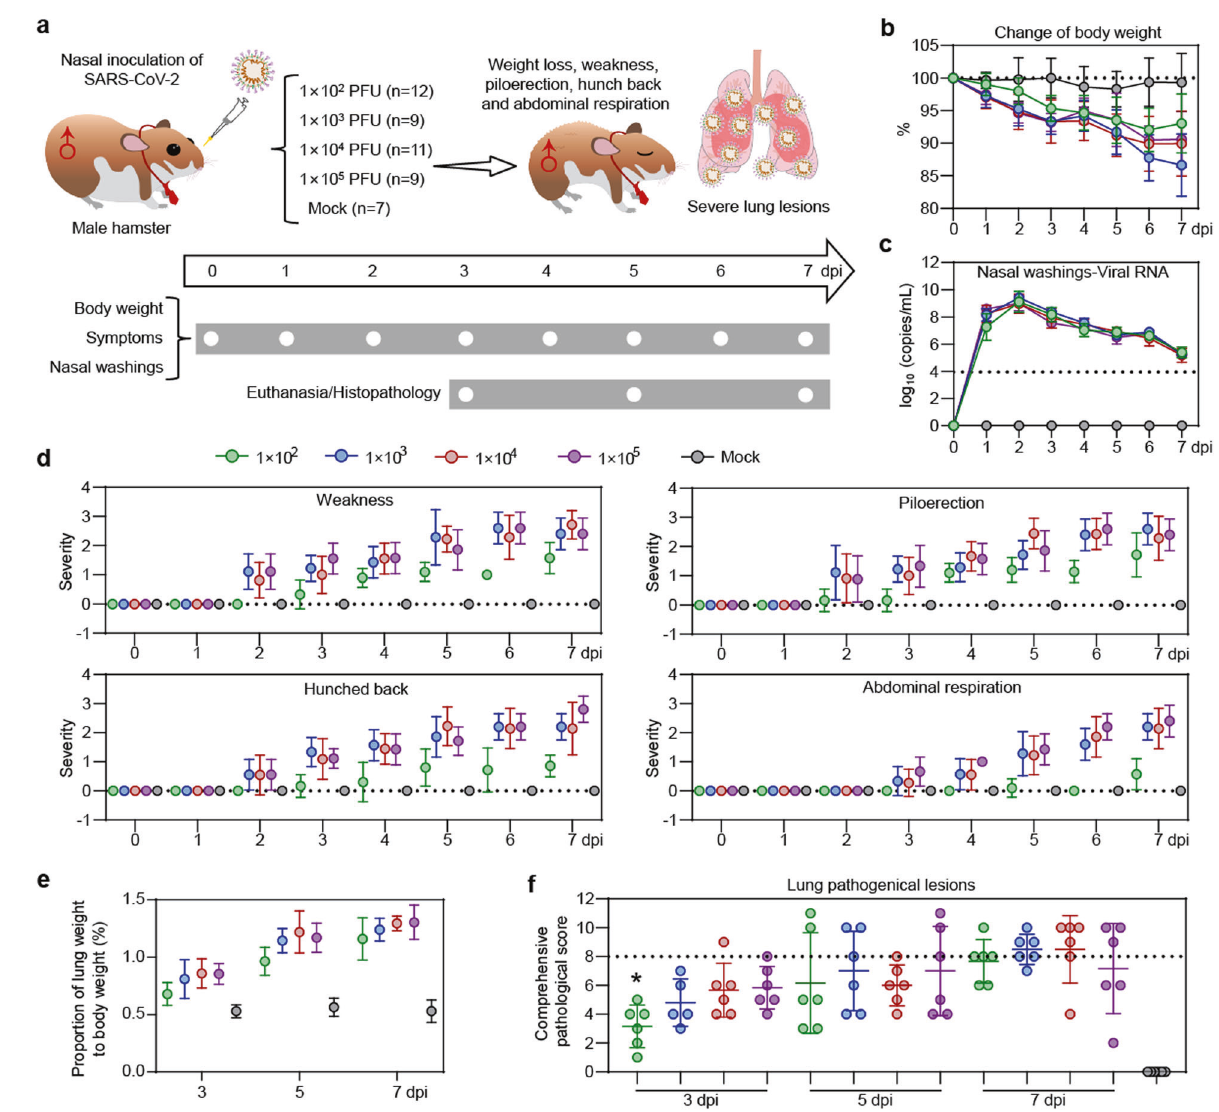
Fig. 3 Symptoms and viral shedding in male hamster intranasally inoculated with varied doses of SARS-CoV-2. a Schematic diagram of SARS-CoV- 2 infection and animal operations. Male hamsters were nasally inoculated with 10 2 – 10 5 PFU of SARS-CoV-2, respectively. Body weight and symptoms were daily observed. Nasal washings were daily collected. Animals were euthanized at 3, 5, and 7 dpi for lung histological analysis, respectively. b Change of body weight. c PCR detection for viral RNA levels in nasal washings. d Daily observation for typical symptoms includes weakness, piloerection, hunched back, and abdominal respiration. Each symptom was scored based on the severity of none (0), moderate (1), mild (2), severe (3), and very severe (4), respectively. Detailed data of individual animals in ( b – d ) were shown in Supplementary Figs. 10 – 12. e Ratio of lung weight to body weight of indicated male hamsters at 3, 5, and 7 dpi, respectively. Hamsters without SARS-CoV-2 infection were set as mock controls ( n = 2/group). f Comprehensive pathological score of lung sections for lung sections collected from male hamster nasally inoculated